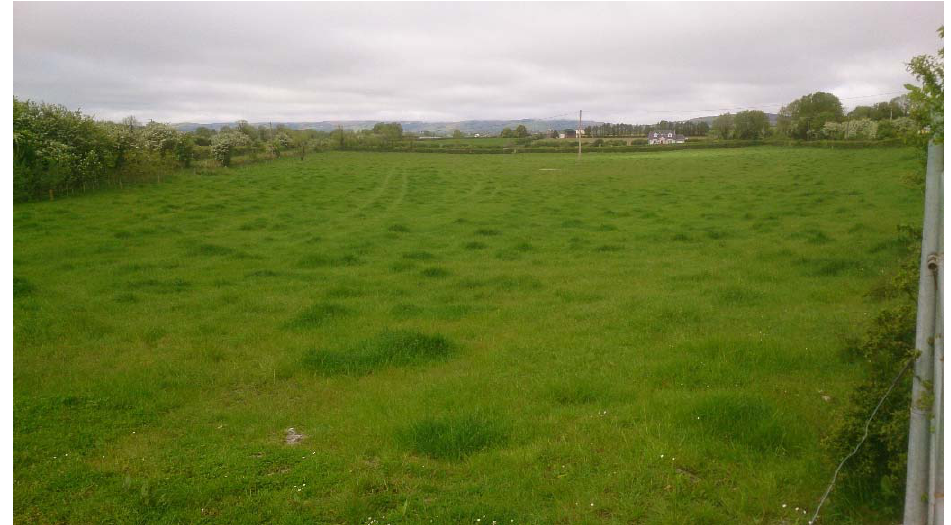
Figure A2. Site TL, looking west. A field of rich grass pasture sloping gently right to left. The highest selenium values are in a zone in the centre of the field (Figure 2).